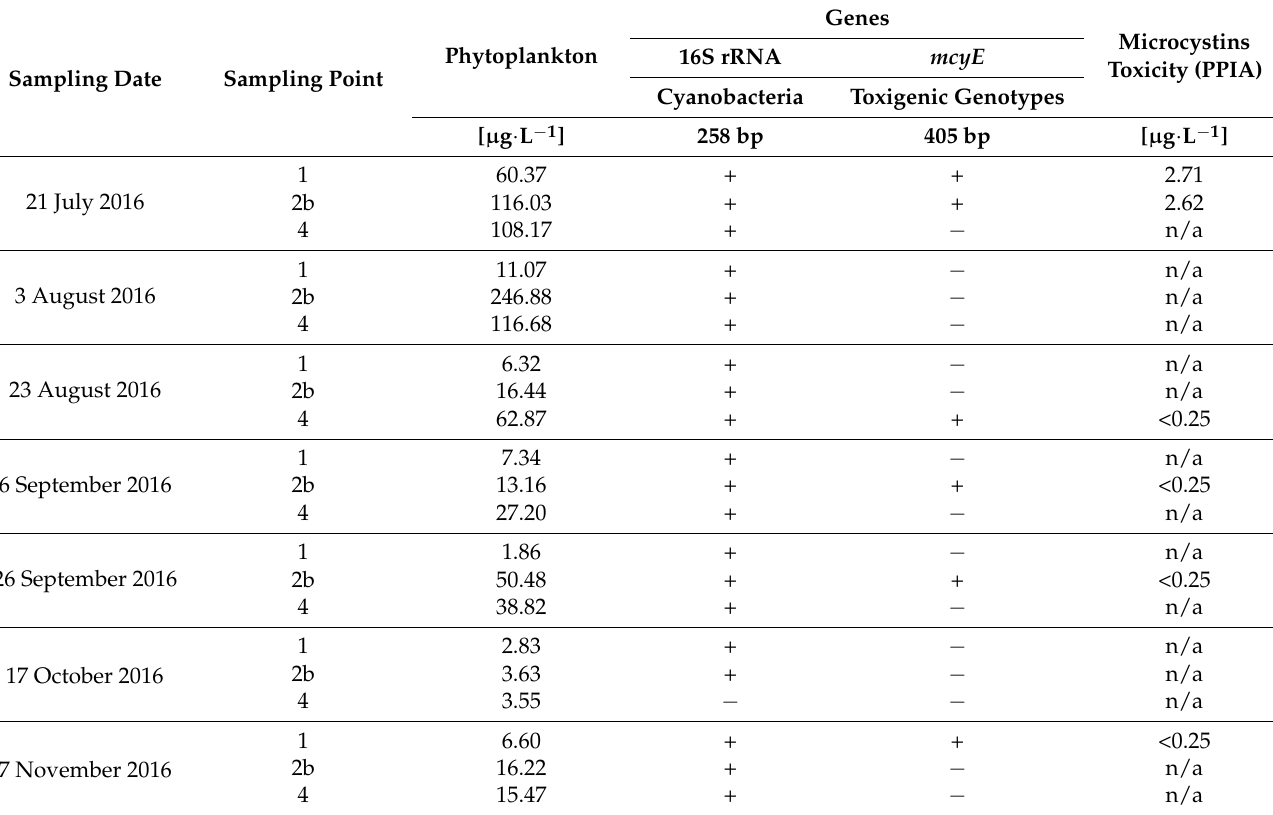
Table 4. The amount of phytoplankton (based on the concentration of chlorophyll A and the presence of cyanobacteria and their toxins (microcystins), in specific control points on the Struga Gnie´znie´nska (1), in the biofiltration segment in the pond (2b) and behind the SED-BIO system (4), in the year